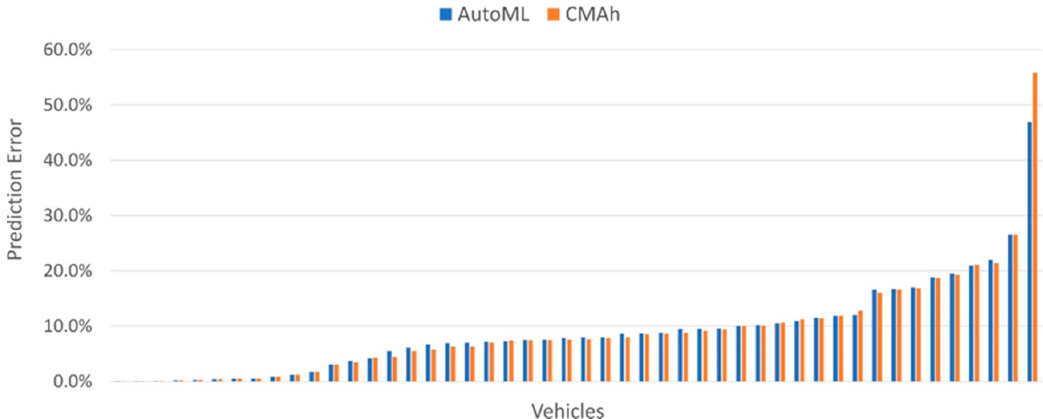
Figure 6. Prediction errors (Perr) for each of the 48 vehicles for the AutoML and CMAh models.